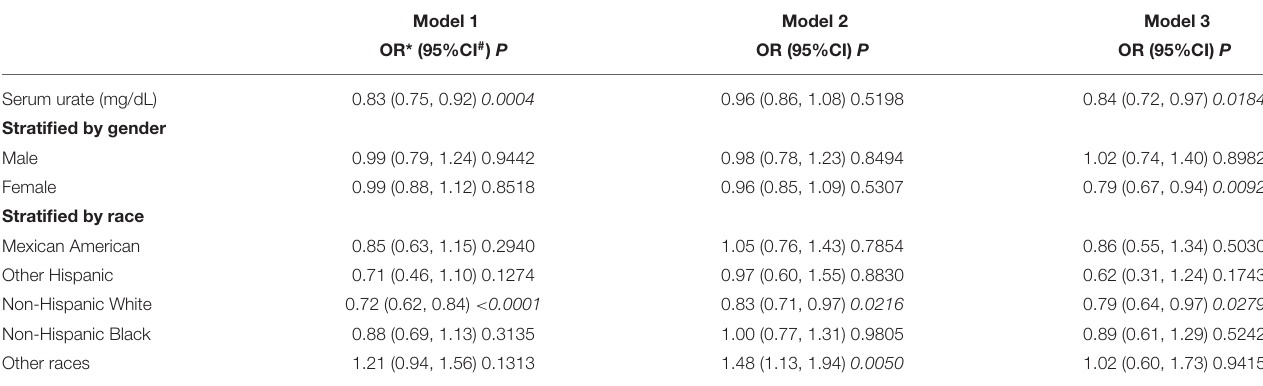
TABLE 2 | Association between serum urate and